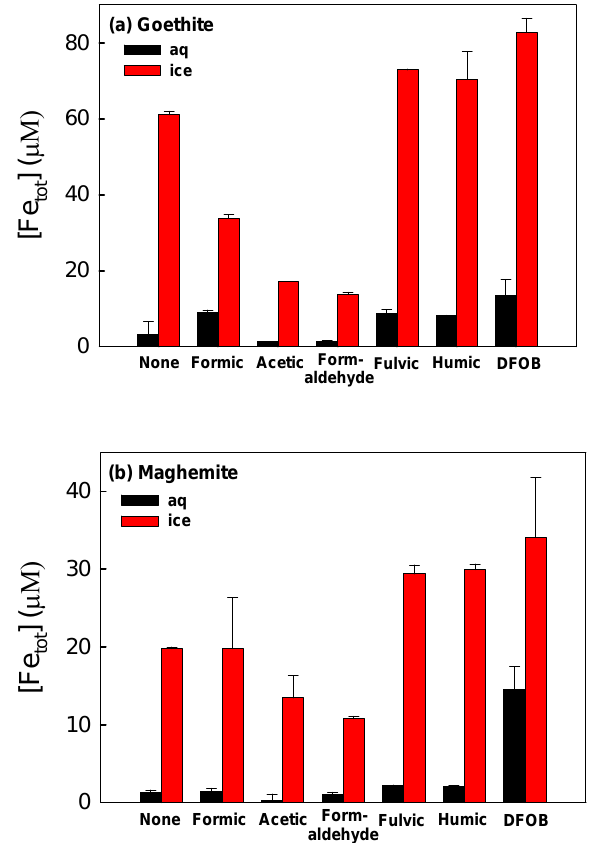
Fig. 1. Production of total dissolved iron from (a) goethite ( α -FeOOH) and (b) maghemite ( γ -Fe 2 O 3 ) under dark condition in the presence of various organic complexing ligands in water (25 ◦ C) and ice ( − 20 ◦ C) after 72h. Experimental conditions: [ α -FeOOH or γ -Fe 2 O 3 ] i = 0.2gL − 1 , [organic ligand] = 6mM, [fulvic or humic acid] = 1 ppm, [DFOB] = 50 μ M, and pH i = 3.00 ± 0.05.